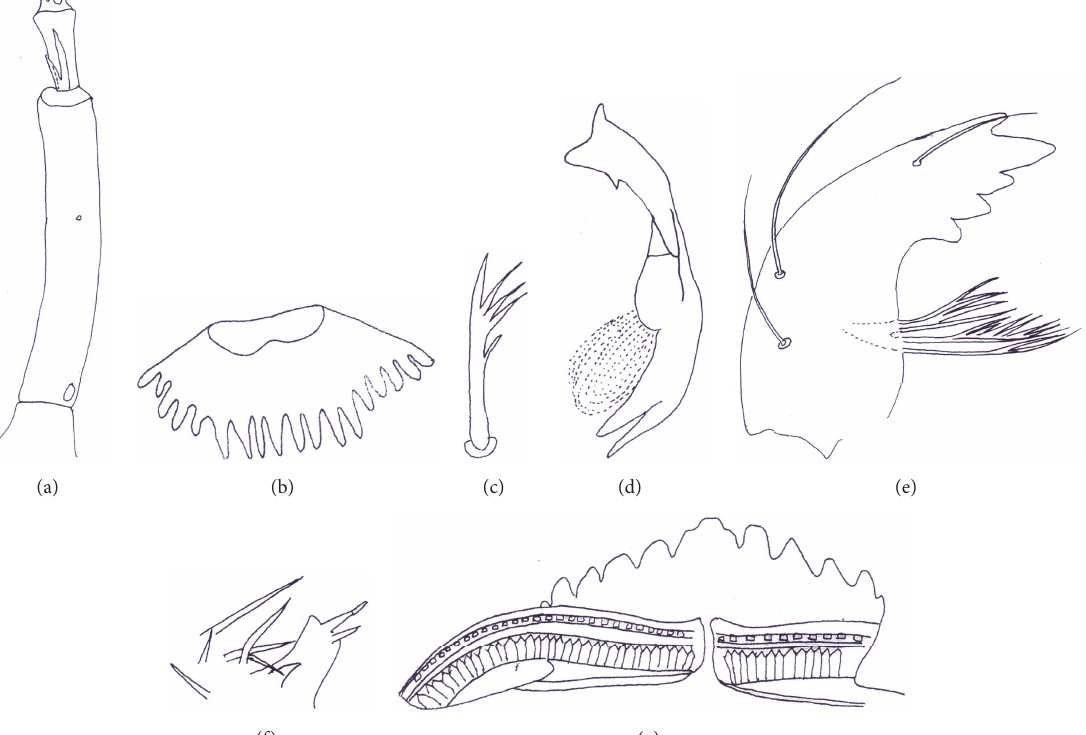
Figure 5: Rheotanytarsus spinicornus n. sp., larva: (a) antenna; (b) pecten epipharyngis; (c) S I of labrum; (d) premandible; (e) mandible; (f) maxillary palp; and (g)